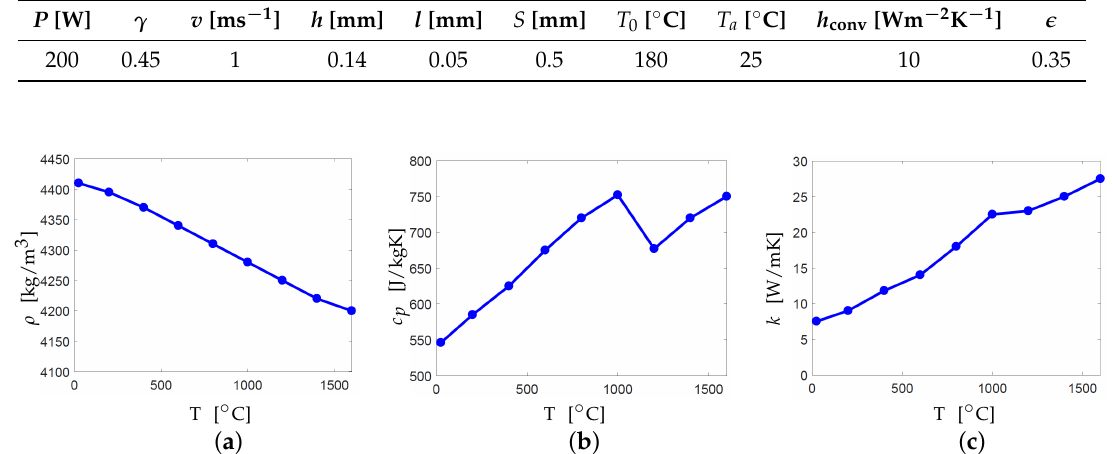
Table 1. List of modeling parameters used for thermal analysis of LPBF process.